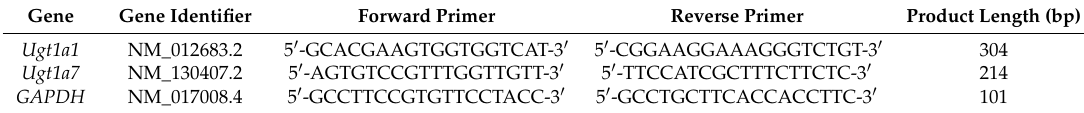
Table 6. Designed primers used for qRT-PCR analysis, and expected PCR fragment